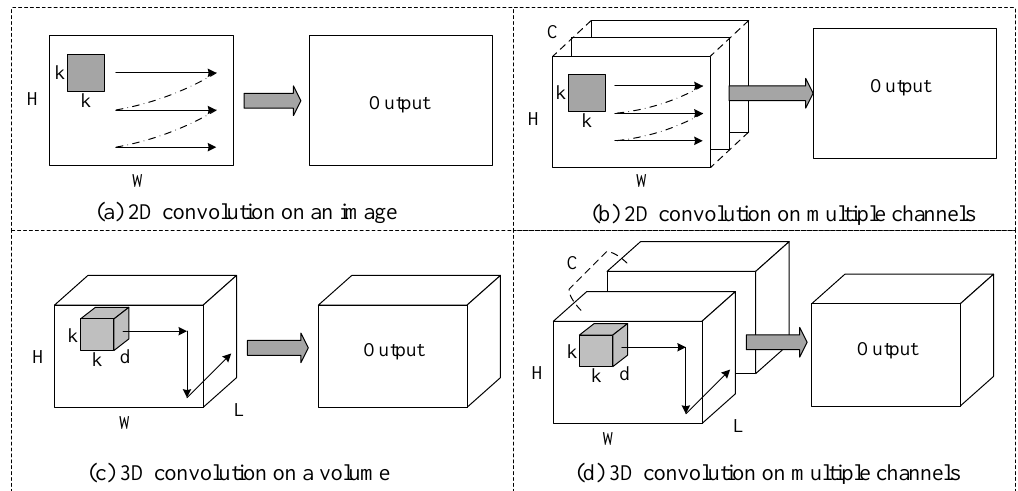
Figure 1. 2D and 3D convolution operations. Applying 2D convolution on an image ( a ) or multiple channels of image ( b ) results in an image. Applying 3D convolution on a video volume ( c ) or multiple channels of video volume ( d ) results in another